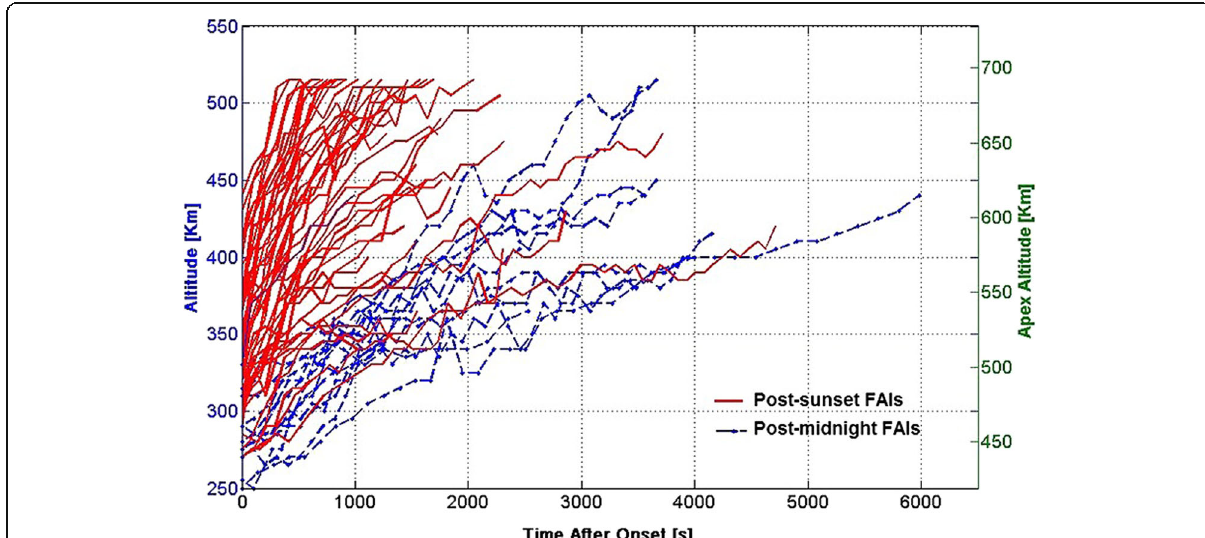
Fig. 7 Temporal variation of the top altitudes of the FAIs observed by the EAR during the growth phase. The left vertical axis shows the altitude of the location where the EAR radar beam is perpendicular to the magnetic field line. The right vertical axis shows the apex altitude of the geomagnetic field line connecting to the point measured with the EAR (after Dao et al. 2016)